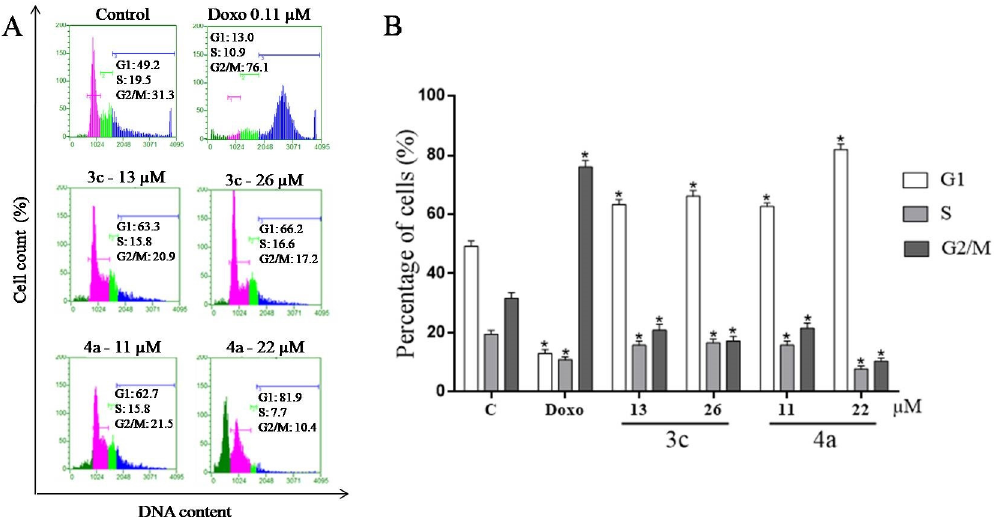
Figure 6. E ff ect of compounds 3c and 4a on the cell cycle of HL-60 cells after 72 h of incubation. ( A ) Cell cycle analysis was performed using flow cytometry and representative histograms on di ff erent colors representing show the distribution of cells in the G0 / G1, S and G2 / M phase. ( B ) Summary histograms indicating the percentage of cells in each phase are presented. Doxorubicin (Doxo, 0.11 µ M) was used as a standard drug. C = control, the cells were treated with the vehicle (DMSO; 0.1%). Results are expressed as mean ± SD of at least three di ff erent experiments performed in triplicate. * p < 0.05 compared with the negative control by ANOVA followed by Student Newman-Keuls